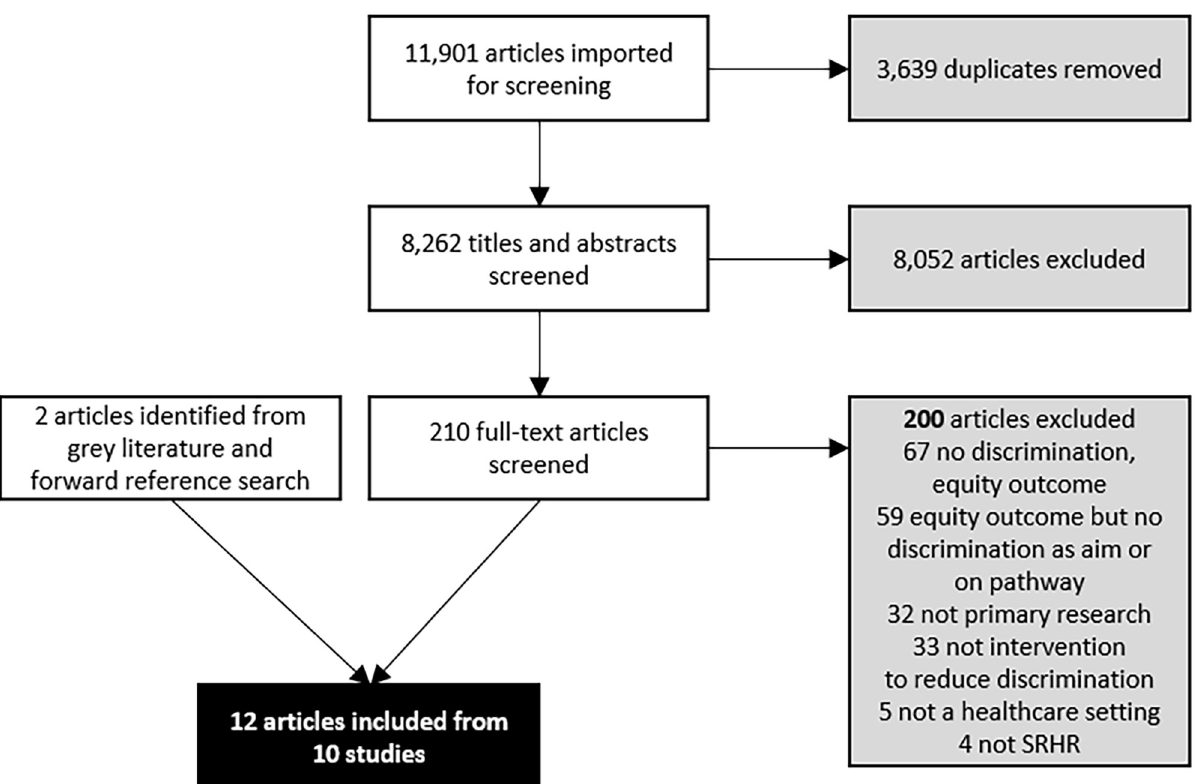
Fig 2. PRISMA diagram. This figure depicts the PRISMA flow diagram, detailing the database searches, number of abstracts and full texts screened, reasons for exclusion, and included studies and articles.